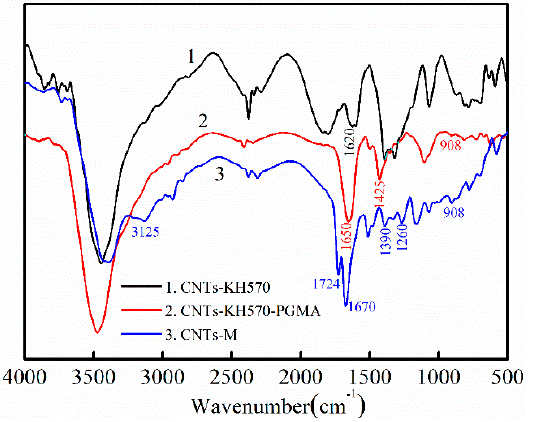
Figure 2. IR spectrum of (1) CNTs-KH570, (2) CNTs-KH570-PGMA and (3) CNTs-M.